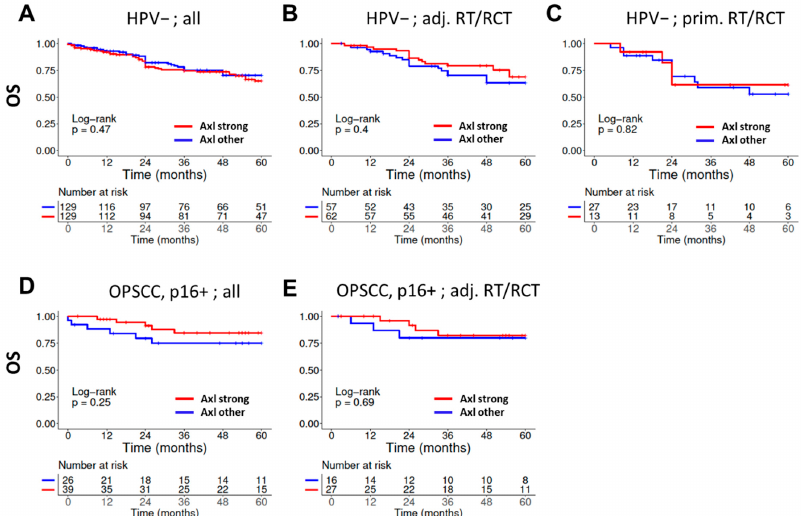
Figure 2. Association of overall survival with Axl expression and treatment. Axl expression was categorized as either strong or other , which includes all samples scored as negative , weak, or moderate . ( A ) All patients with HPV-negative HNSCC. ( B ) Patients with HPV-negative HNSCC treated by surgery and adjuvant RT/RCT and ( C ) with primary RT/RCT. ( D ) All patients with p16-positive OPSCC and ( E ) those treated with surgery and adjuvant RT/RCT.